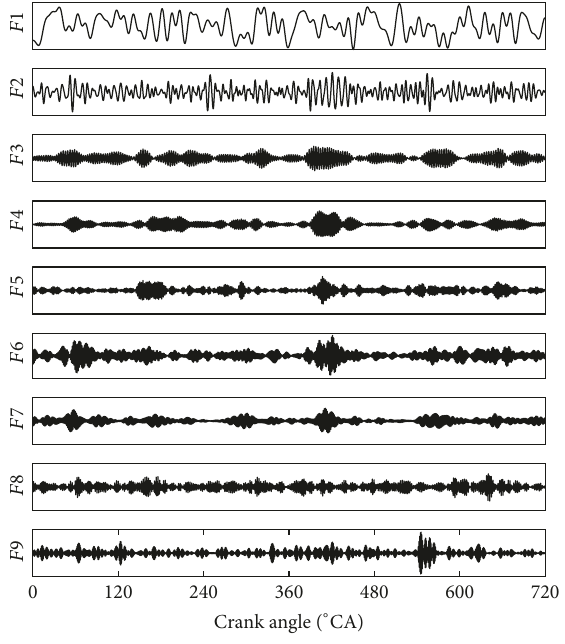
Figure 19: EWT calculation results.